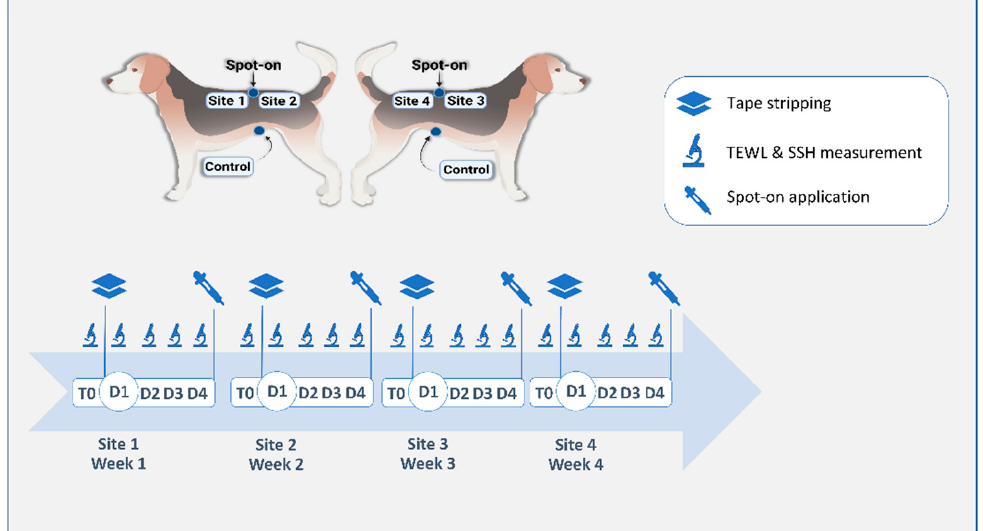
Figure 1. Schematic description of the study protocol. Four test sites were defined on the dorsum of the animal, as well as a spot-on site between the four test sites and a control site on the ventral abdomen. Tape stripping was performed on a single test site on the first day of the week corresponding to the site number (D1). Transepidermal water loss (TEWL) and skin surface hydration (SSH) were measured before (T0) and one hour after tape stripping (D1) and on three successive days after tape stripping (D2, D3, D4). Spot-on was applied on the defined site after measurements, on D4 of Weeks 1, 2 and